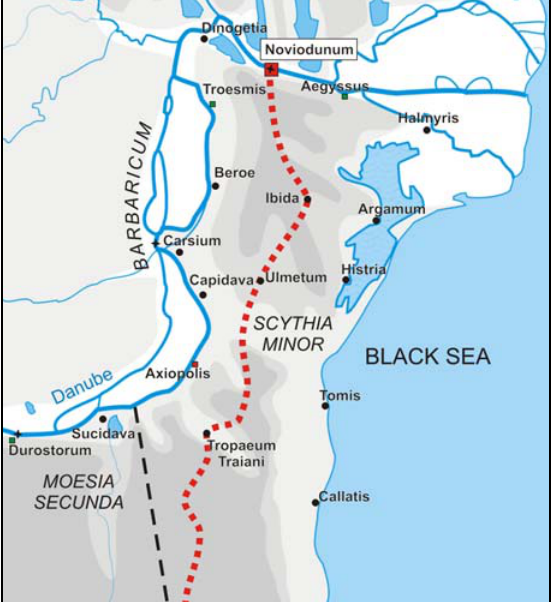
Figure 1. Location of Noviodunum , at the northern end of Marcianopolis road, in the Late Antiquity.